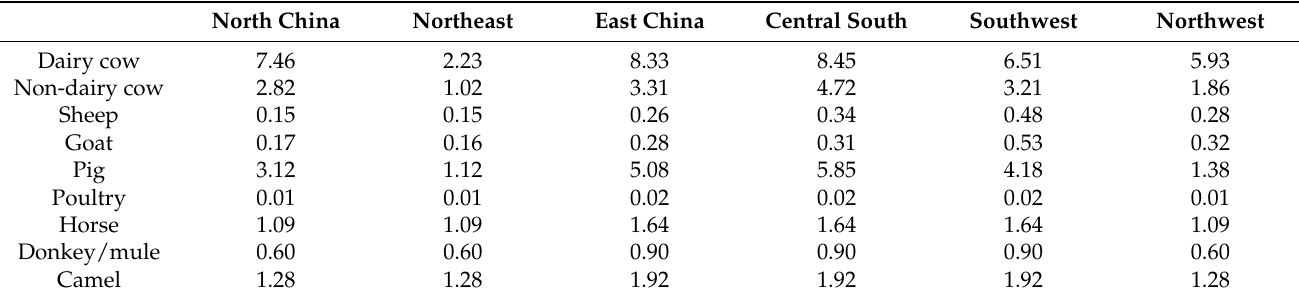
Table 2. Methane emission factors from manure